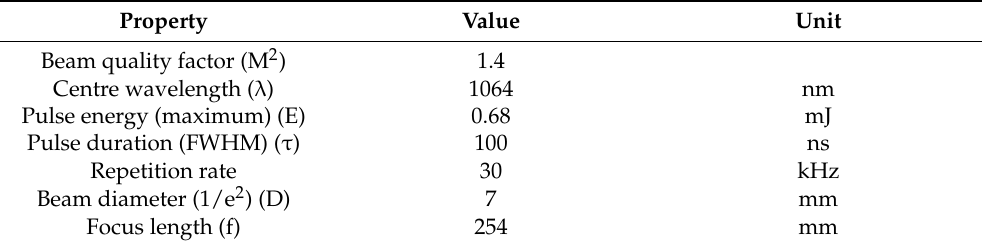
Table 3. Laser setup properties used in the finite element simulation [50,51].